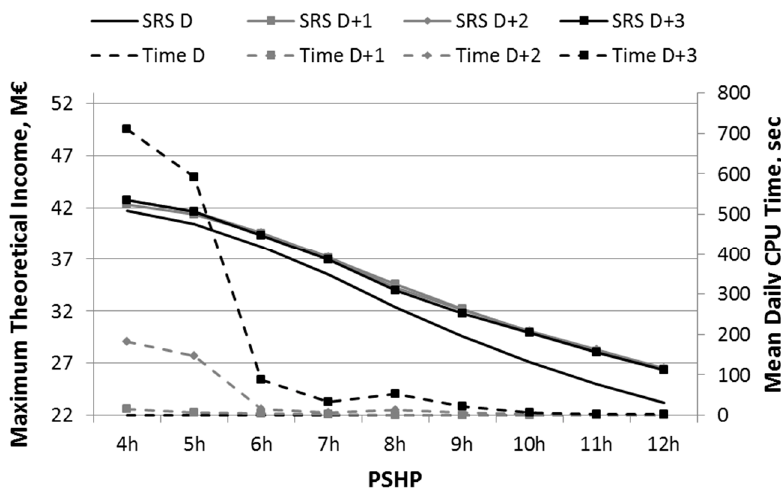
Figure 2. Annual maximum theoretical income, in millions of €, and the mean CPU time consumption of each daily problem, in seconds, for n days of look-ahead period and without look-ahead period. Table 3. Mean CPU time consumption of each daily problem, in seconds, for n days of look-ahead period. Strategy